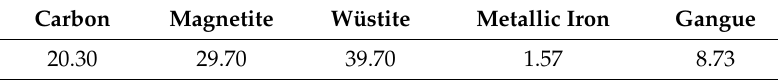
Figure 5. SEM images of the CCB sample: ( a ) × 200 ( b ) × 3000.